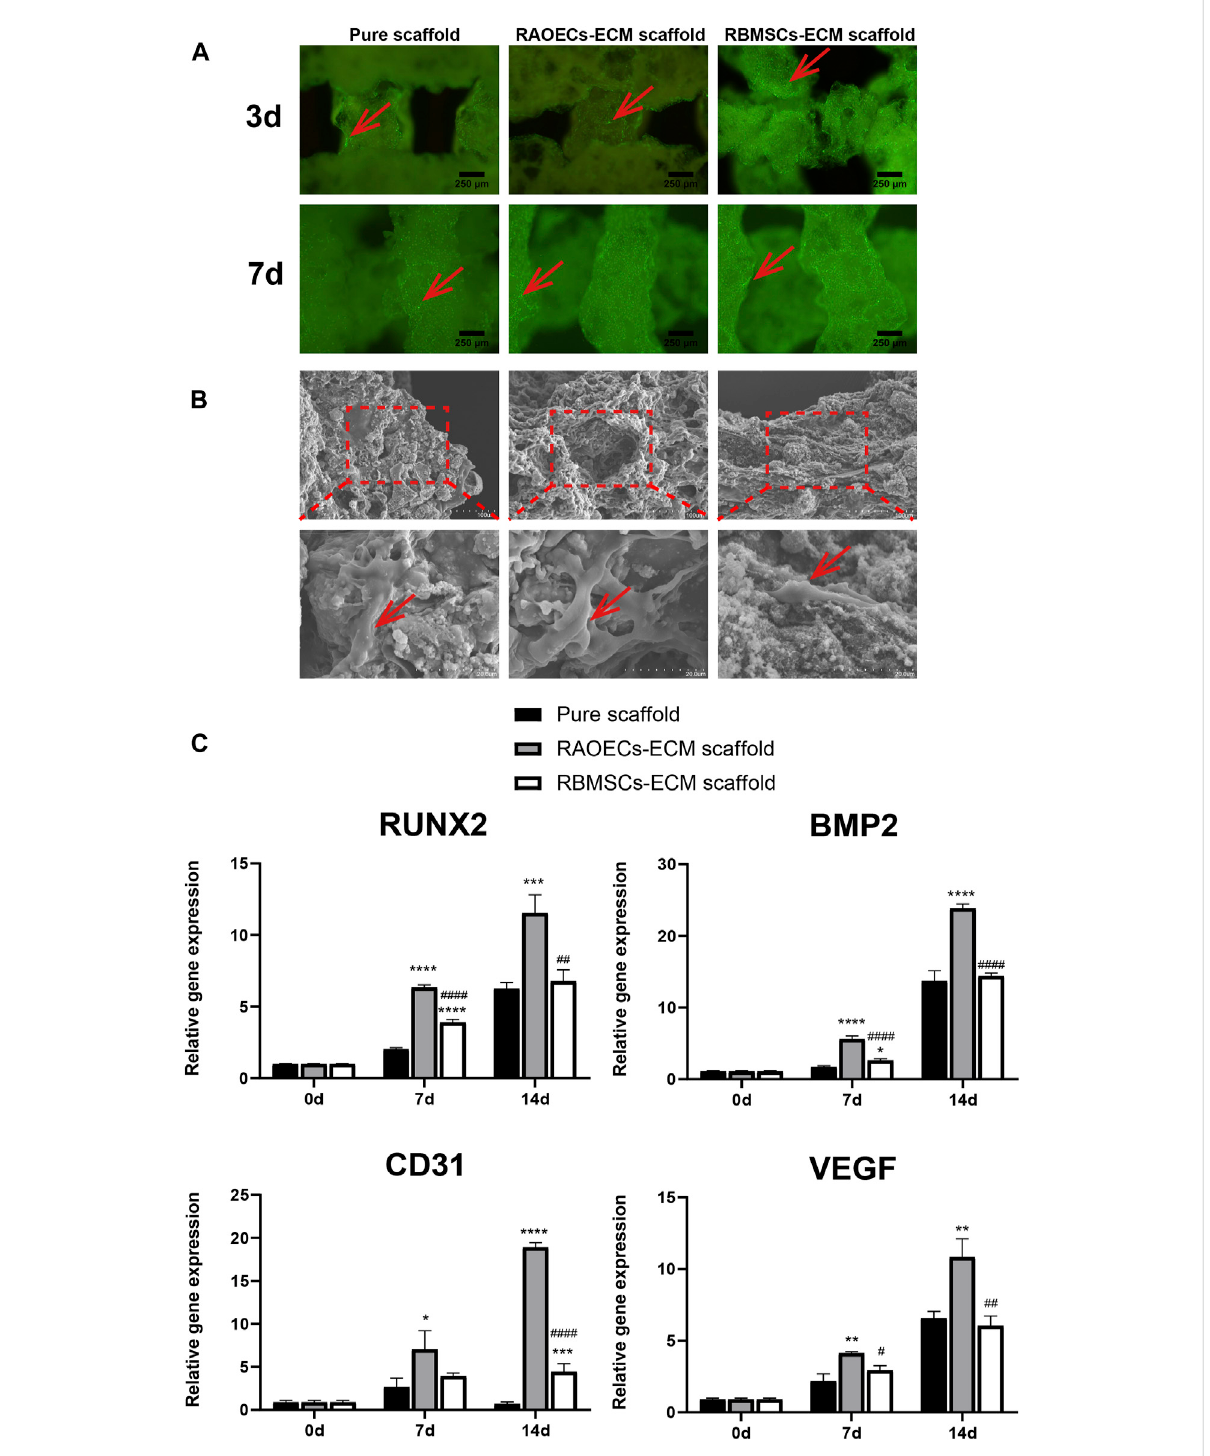
FIGURE 2 Cell adhesion, proliferation and RT – PCR assessment. (A) Fluorescence microscopy images of RBMSCs – seeded scaffolds after Calcein AM staining. (B) Scanning electron micrographs of RBMSCs (arrows) adhering to the surfaces of scaffolds at various magni fi cations. (C) The expression levelsofosteogenicandvascularization – relatedgenesafter0,7and14 dofinduction.(Signi fi canteffectcomparedtopurescaffold: p p < 0.05, pp p < 0.01, ppp p < 0.001, pppp p < 0.0001. Signi fi cant effect compared to the RAOECs – ECM scaffold: # p < 0.05, ## p < 0.01, #### p < 0.0001, n =